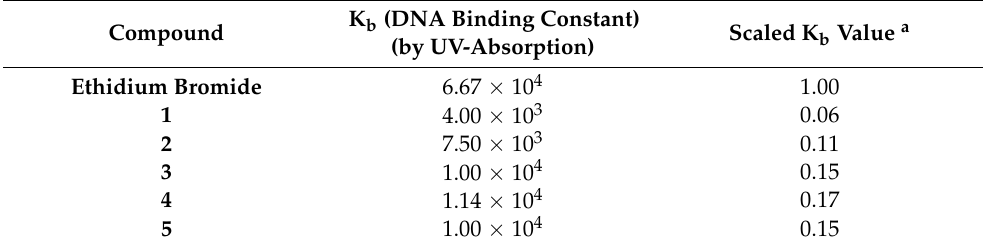
Table 2. The DNA binding affinities toward the CT-DNA measured in 5 mM Tris HCl buffer (pH =